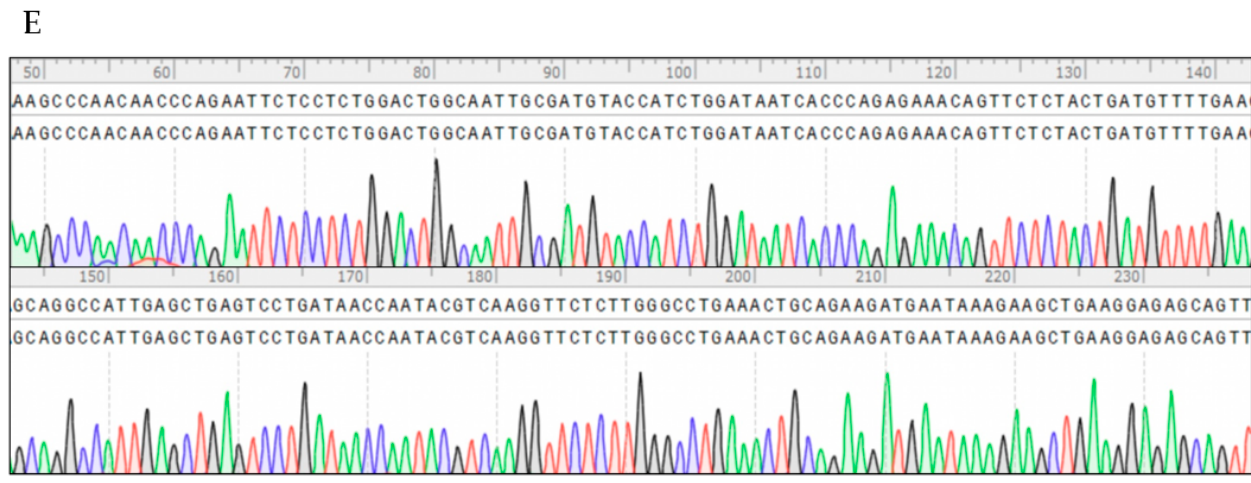
Figure 1. Successfully established TaqMan-MGB RIG-G gene mRNA real-time quantitative PCR detection method. ( A ) The linear relationship between log of concentration and Ct values for a series of dilutions from 1 × 10 7 to 1 × 10 1 of RIG-G amplicon standard (R 2 = 0.999). Each dilution of RIG-G plasmid amplicon standard was assayed in duplicate by TaqMan-MGB real-time fluorescence quantitative PCR. ( B ) Serial dilutions from 1 × 10 7 to 1 × 10 1 of RIG-G plasmid amplicon standards, the curves from left to right correspond to 1 × 10 7 , 1 × 10 6 , 1 × 10 5 , 1 × 10 4 , 1 × 10 3 , 1 × 10 2 , 1 × 10 1 copies/uL, respectively. ( C ) RIG-G gene mRNA melting curve. ( D ) Detection of PCR amplification products by 2% agarose gel electrophoresis. M: marker; 1~3: plasmid; 4~6: normal; 7~9: M3 patients; 10: sterilized double distilled water. ( E )The PCR products were sequenced using the Sanger method, and the results showed that the sequence of RIG-G gene was completely consistent.